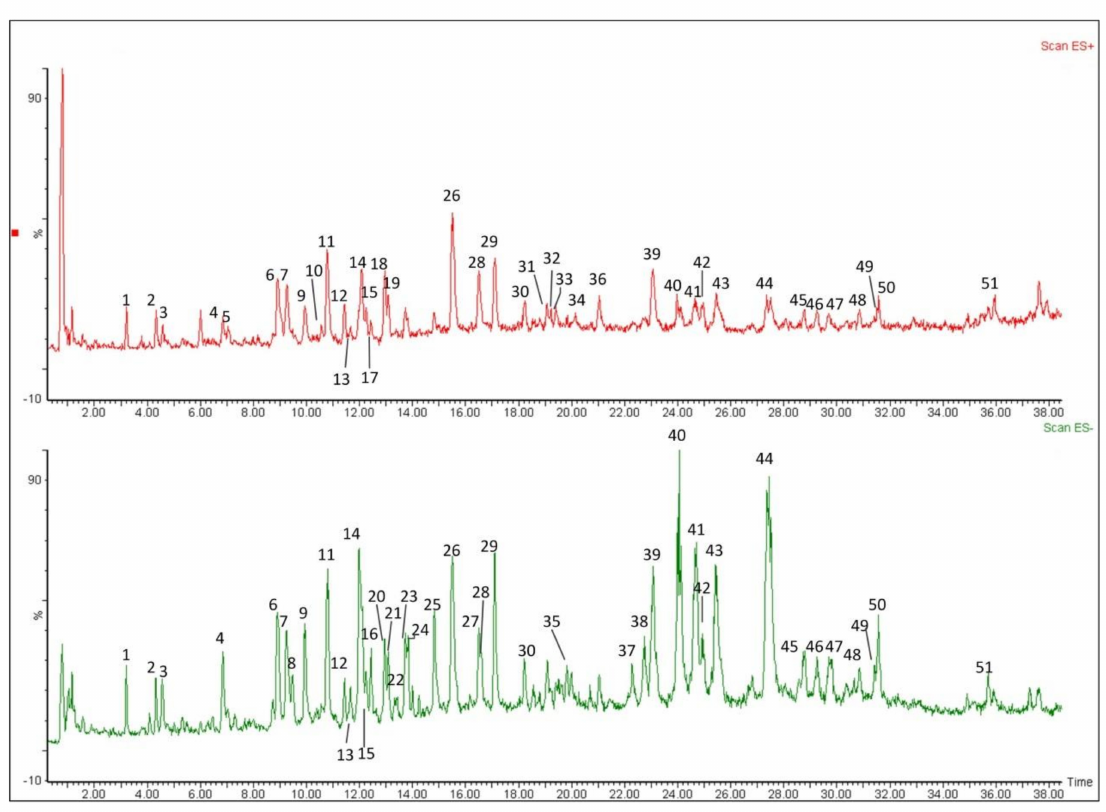
Figure 2. Total ion current chromatograms of substances in the extract of L. rotata , under positive and negative ionization